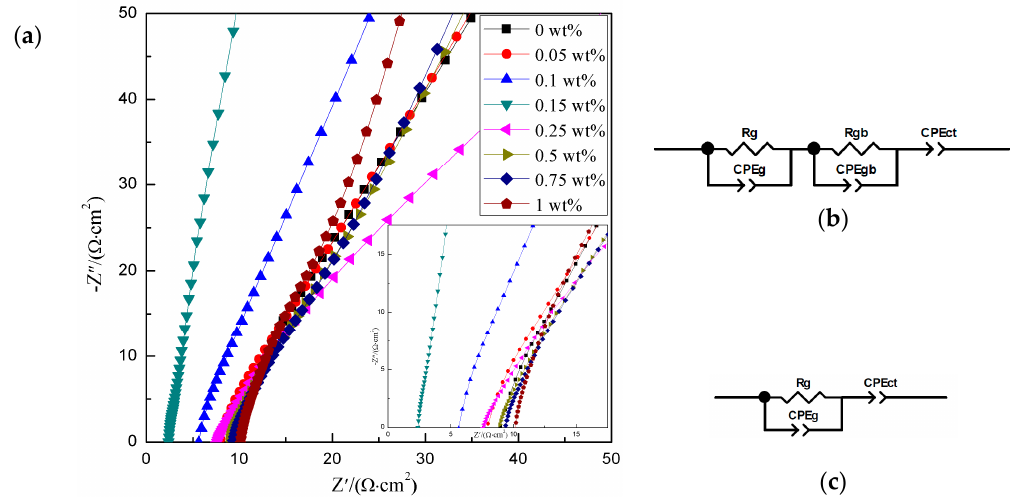
Figure 7. The impedance spectra ( a ) of the sinters with different amounts of Cr 2 O 3 doping at 350 °C; equivalent circuits: ( b ) < 300 °C; ( c ) ≥ 300 °C.